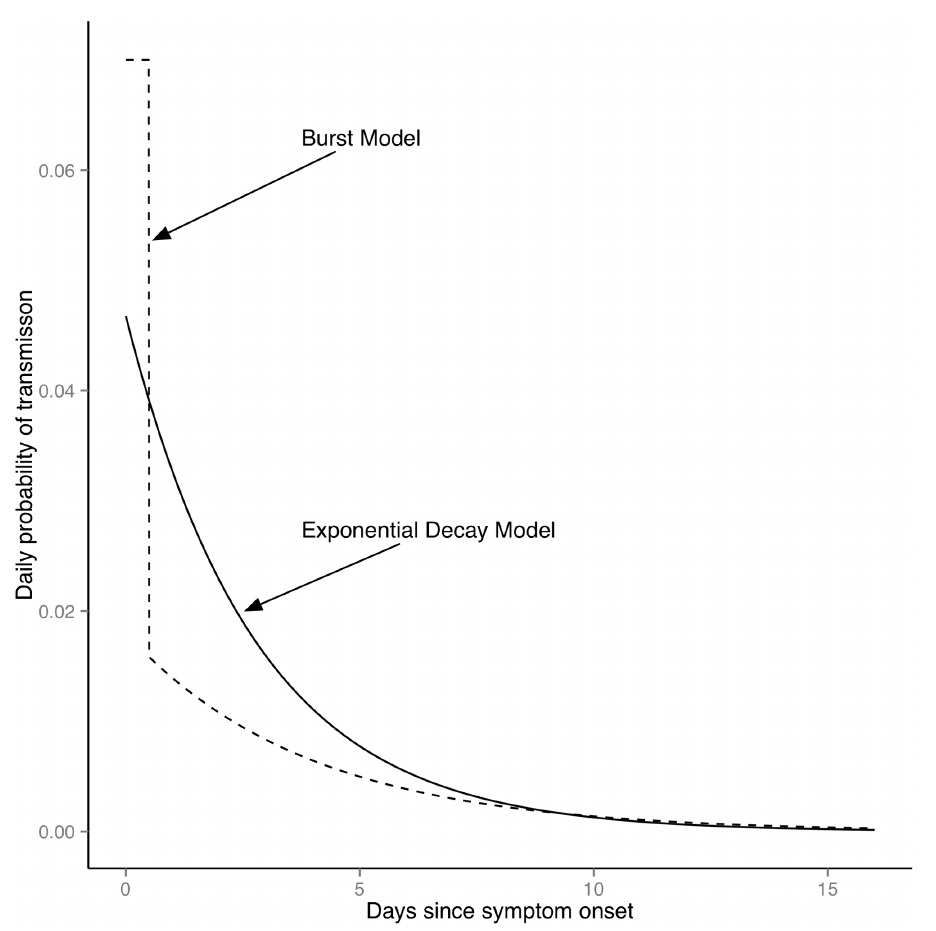
Figure 3. Fitted infectivity profiles for Models 2 & 3. The figure shows infectiousness as a function of time since symptom onset for the estimated values of the exponential decay model (Model 2; solid line) and burst model (Model 3; dashed line).